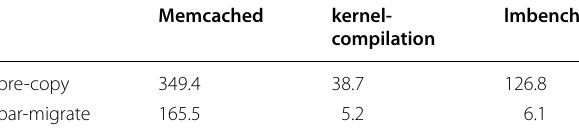
Table 3 Send data in stop-copy phase